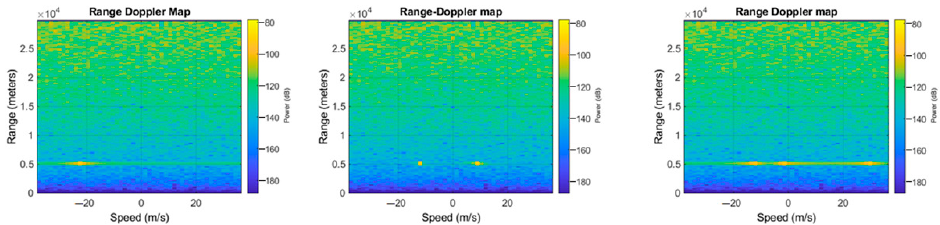
Figure 6. Example of range-Doppler maps generated with fixed positions at different speeds of (respectively, from the left to right) 1, 2, 3 targets.